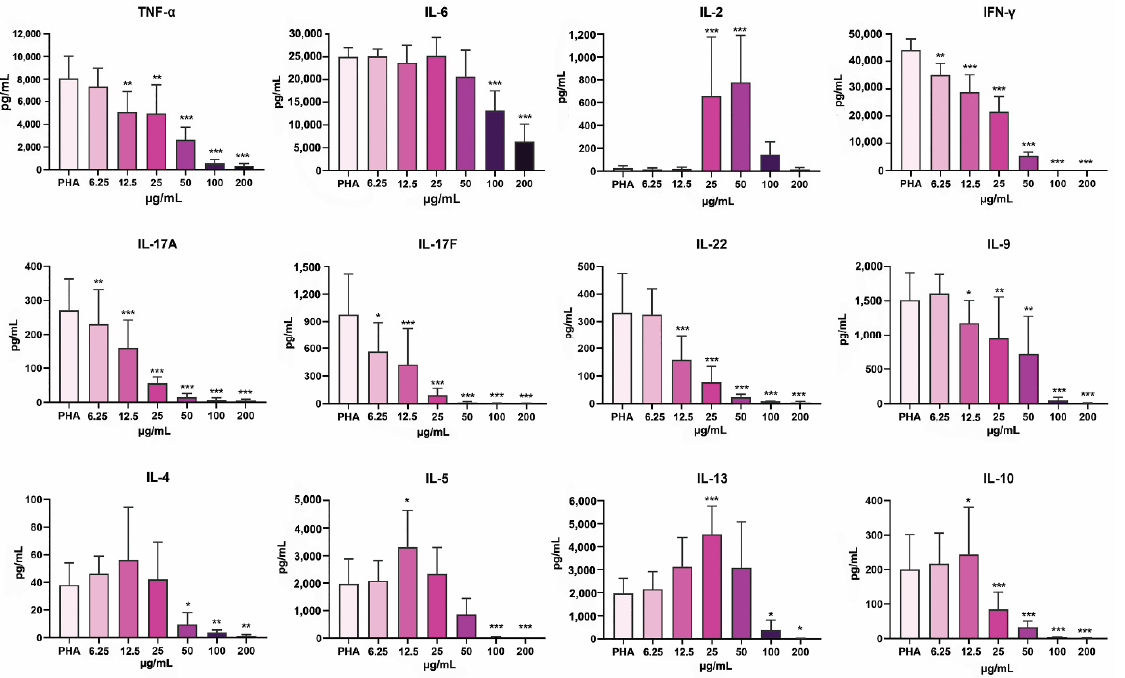
Figure 8. The effects of PoPEx on the production of cytokines by PHA-stimulated PBMC. PBMC (3 × 10 5 /well) were cultured with PoPEx (6.25–200 µ g/mL) or without PPoPEx (PHA) in the presence of PHA (10 µ g/mL) for 3 days, followed by a collection of cell-culture supernatants and measurements of indicated cytokine levels by flow cytometry, as described in Materials and Methods. The data is shown as mean (pg/mL) ± SD from 8 independent experiments. * p < 0.05, ** p < 0.01, *** p < 0.005, compared to control non-treated PHA-PBMC (Friedman test; Dunn’s multiple comparison